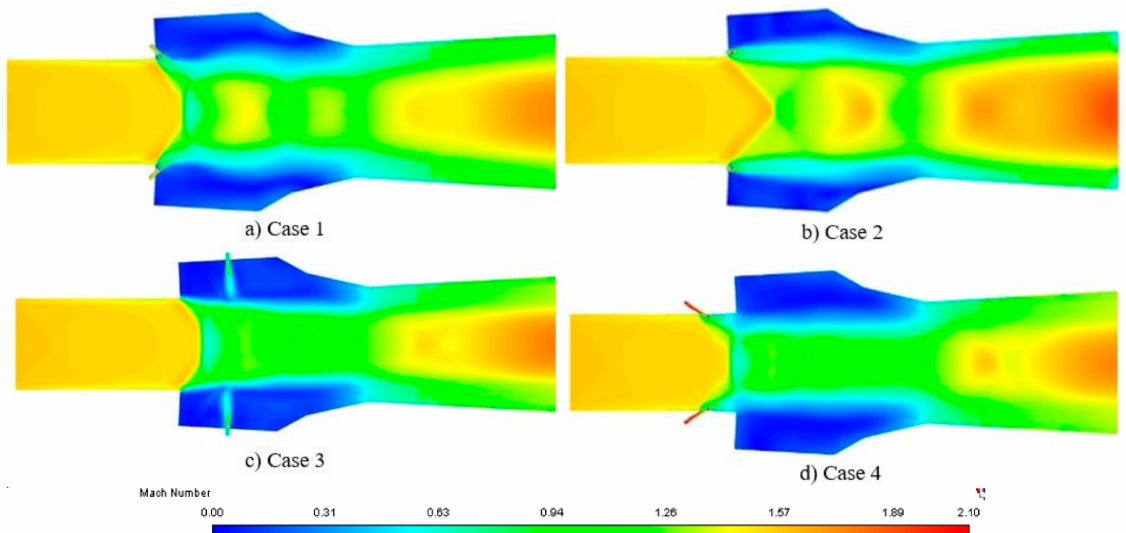
Figure 4. Mach number contour of various injection schemes.